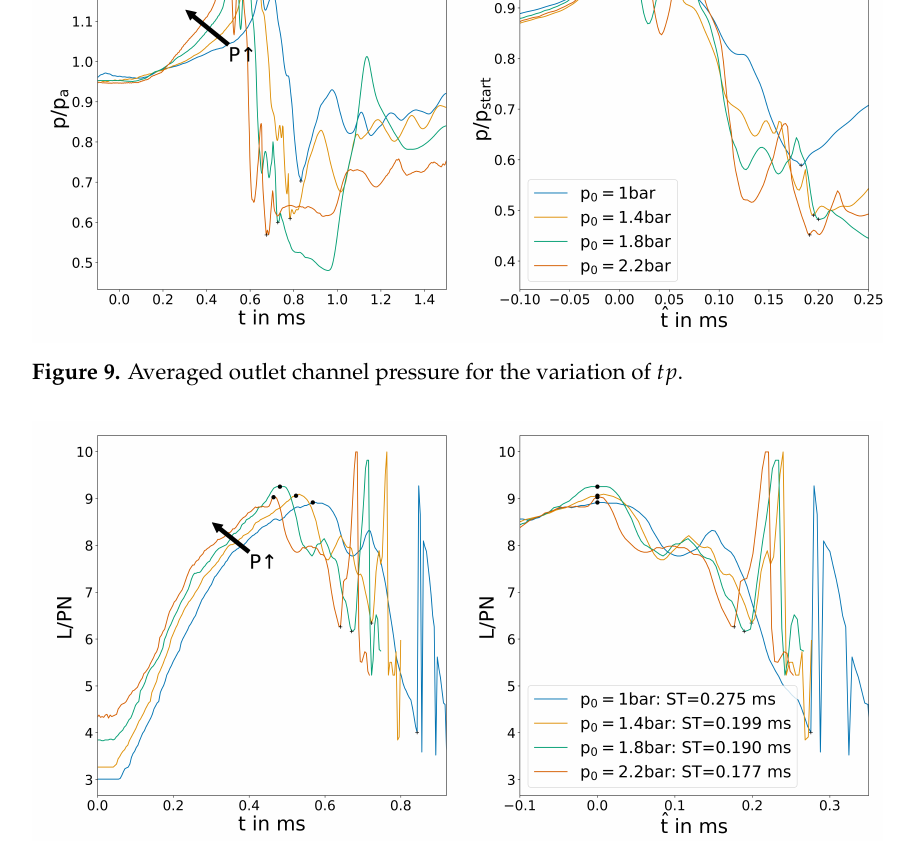
Figure 10. Position of the reattachment point determined by wall shear stress for the variation of p .